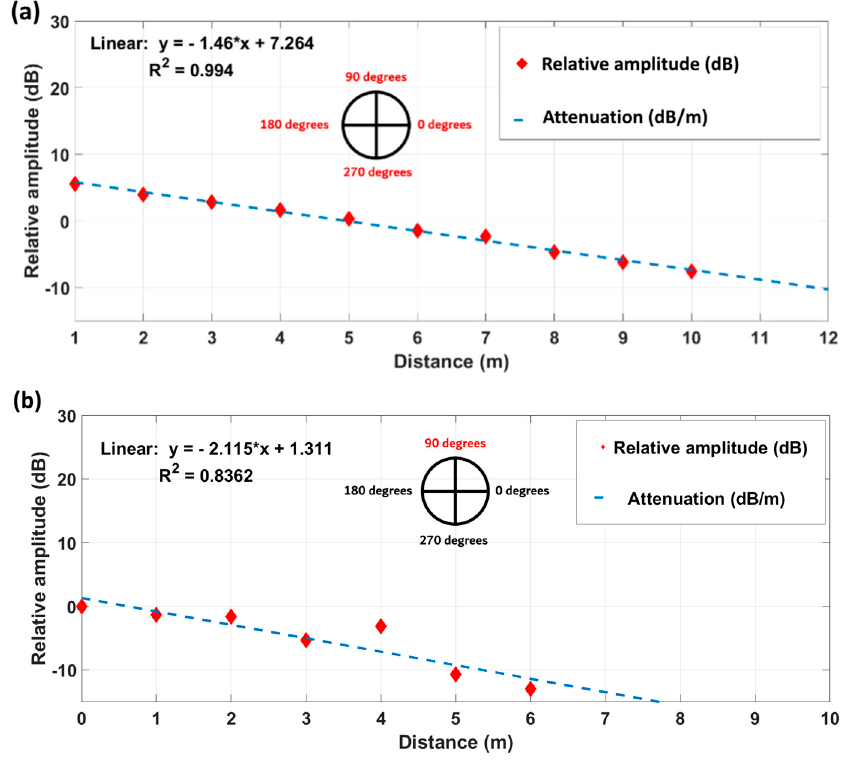
Figure 11. ( a ) Numerical prediction of acoustic attenuation along infinitely long buried MDPE pipe and ( b ) buried MDPE pipe of 6 m length.